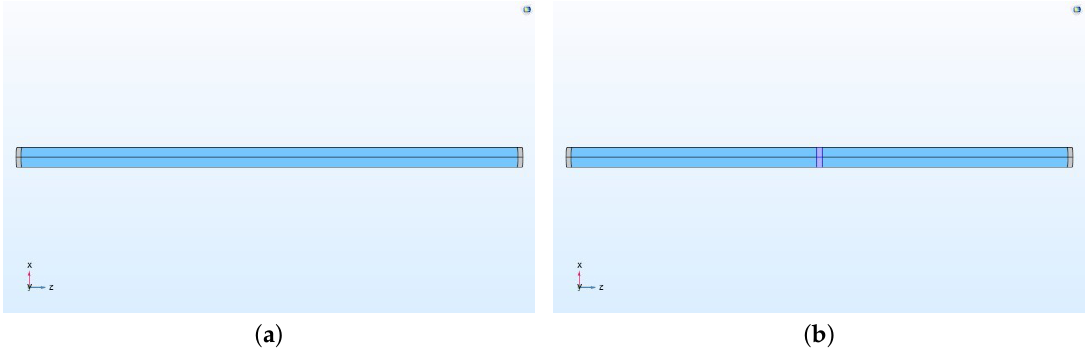
Figure 5. ( a ) 3D model of impedance tube without sample in software. ( b ) 3D model of impedance tube with steel sample in software.